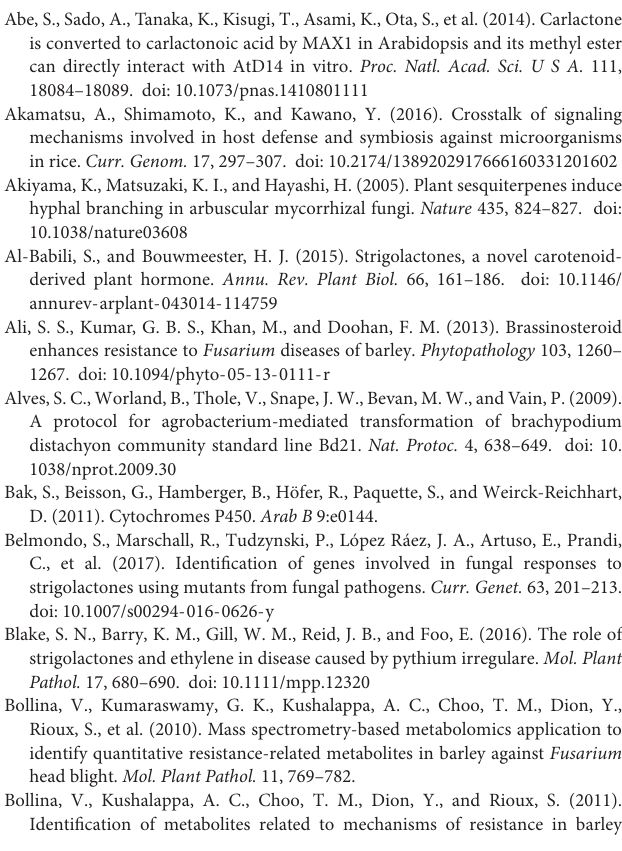
Supplementary Figure 6 | Characteristic germination patterns of macroconidia of the F. graminearum FgDON + exposed at different orobanchol concentrations. Supplementary Table 1 | List of BdCYP711A29 -specific primers used for the construction of overexpressing lines and the selection of TILLING mutant lines.